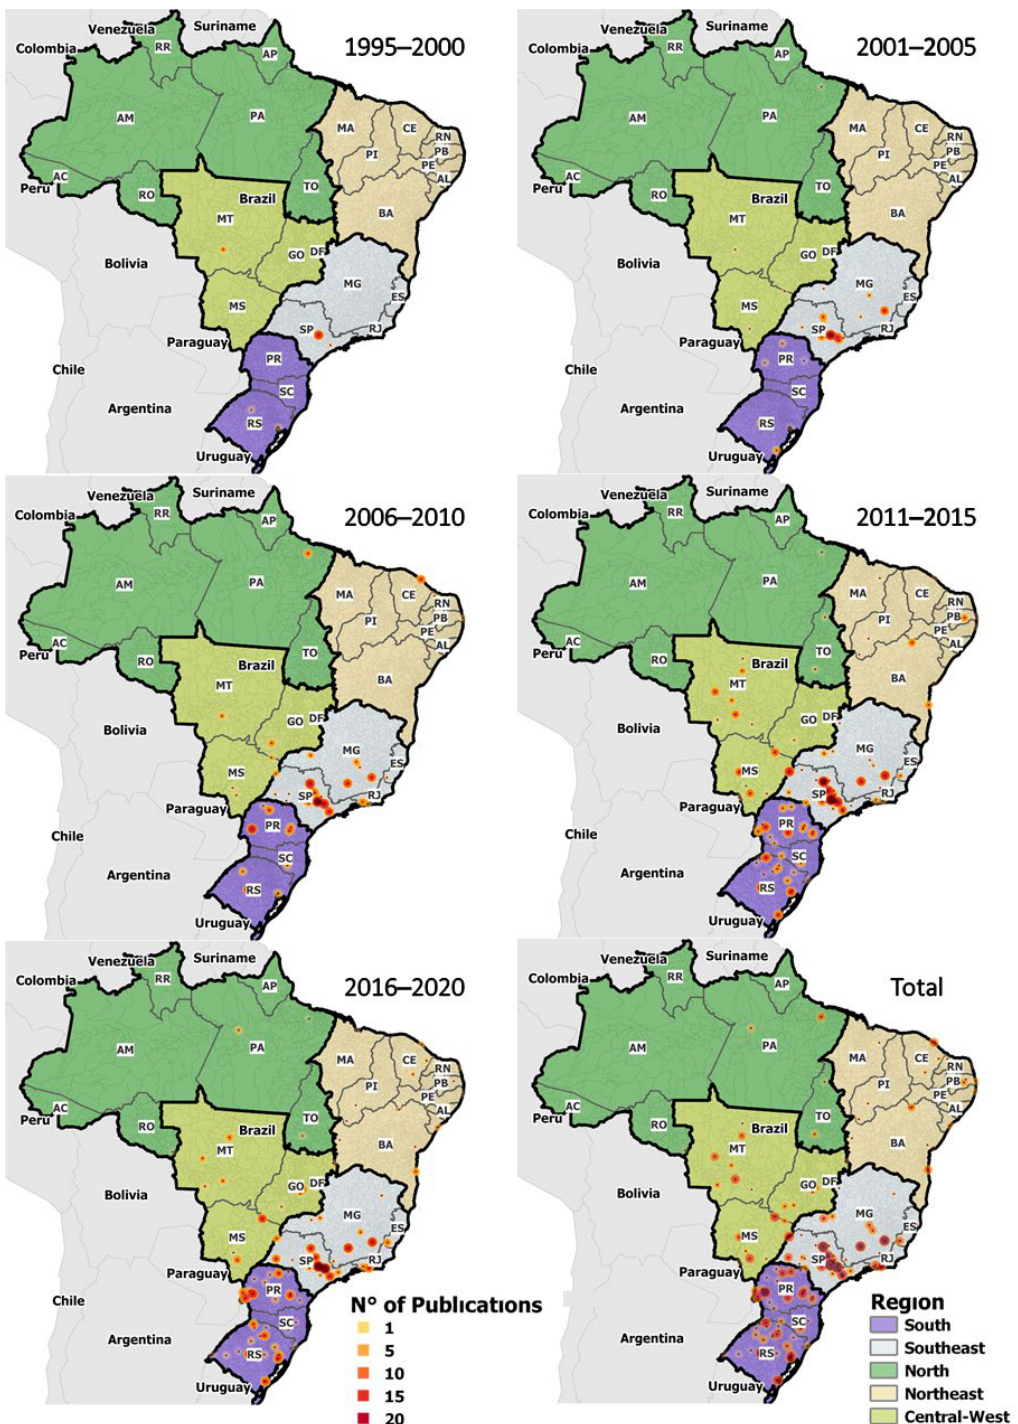
Figure 4. Spatiotemporal distribution of precision agriculture publications over the past 25 years in Brazil. The color and size of the circles are proportional to the frequency of publications in each location. The Brazilian states of Acre (AC), Amapá (AP), Amazonas (AM), Pará (PA), Alagoas (AL), Bahia (BA), Ceará (CE), Maranhão (MA), Paraíba (PB), Pernambuco (PE), Piauí (PI), Rio Grande do Norte (RN), Sergipe (SE), Distrito Federal (DF), Goiás (GO), Mato Grosso (MT), Mato Grosso do Sul (MS), Esp í rito Santo (ES), Minas Gerais (MG), Rio de Janeiro (RJ), S ã o Paulo (SP), Paran á (PA), Rio Grande do Sul (RS), and Santa Catarina (SC) are indicated with their